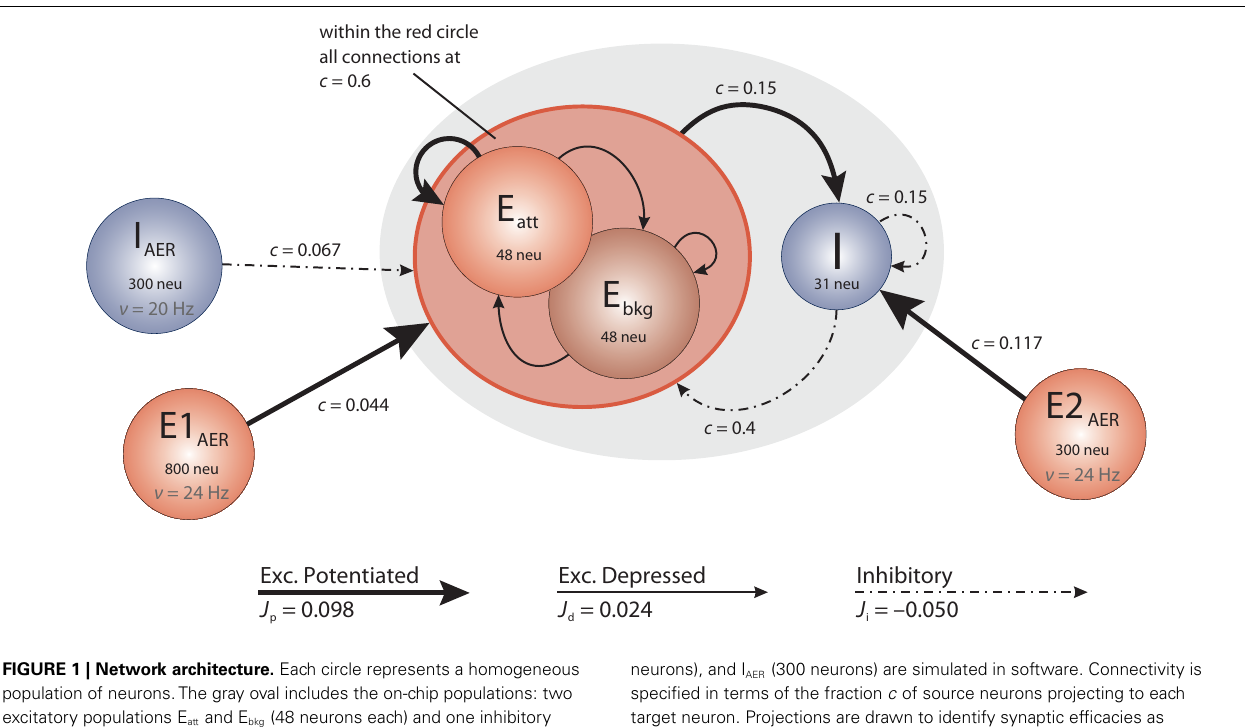
neurons), and I AER (300 neurons) are simulated in software. Connectivity is specified in terms of the fraction c of source neurons projecting to each target neuron. Projections are drawn to identify synaptic efficacies as excitatory potentiated ( J p ), excitatory depressed ( J d ), or inhibitory ( J i